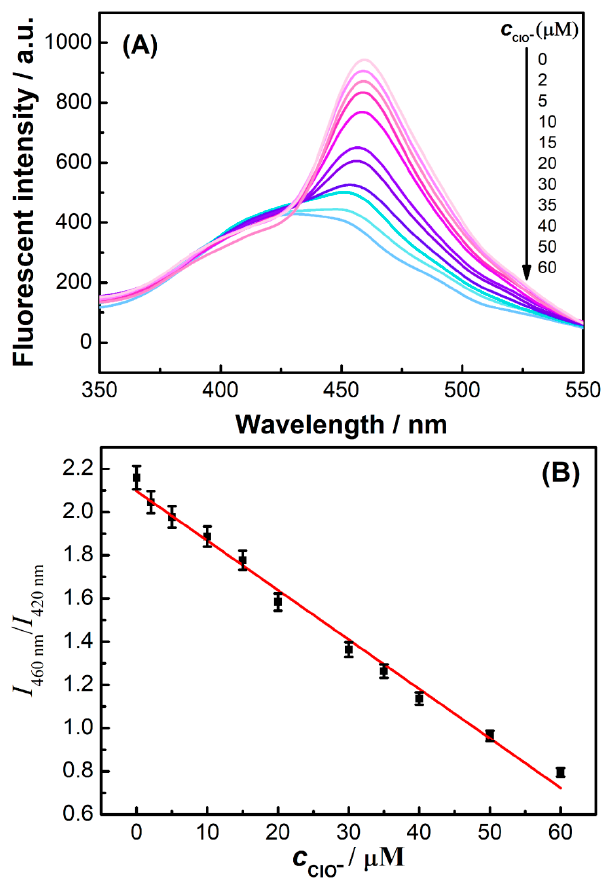
Figure 7. Fluorescence spectra ( A ) and linear calibration diagram ( B ). c (ClO − , μ M): 0, 2, 5, 10, 15, 20, 30, 35, 40, 50, 60; c (probe, μ L): 20; reaction time (min): 5; temperature (°C): 25 (room temperature); 40 mM phosphate buffer solution: pH 8.0. λ ex : 285 nm; λ em : 460 nm. All the error bars represent the standard deviation of the three measurements.